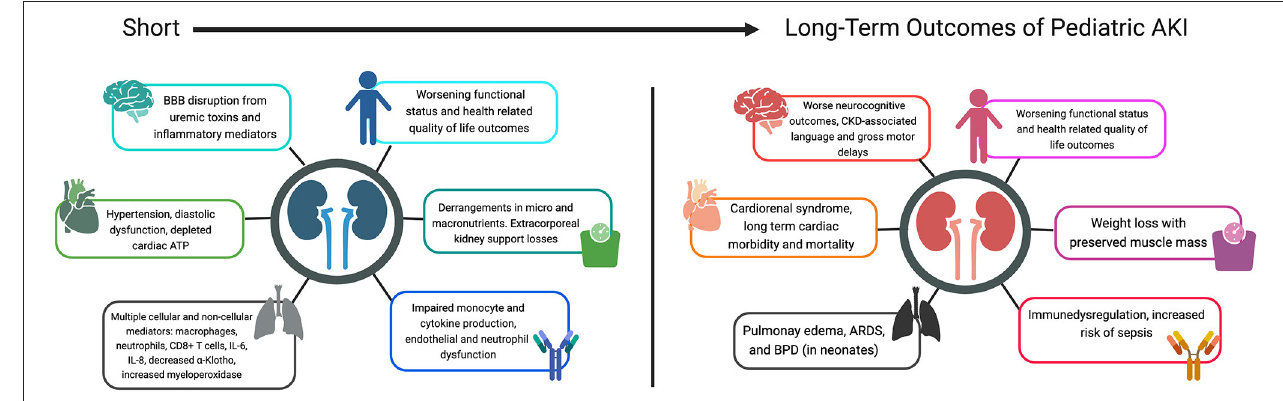
FIGURE 1 | Short and long term outcomes of pediatric AKI. BBB, blood-brain-barrier; ATP, adenosine triphosphate; CD8 + , cluster of differentiation 8; IL-, interleukin; CKD, chronic kidney disease; ARDS, acute respiratory distress syndrome; BPD, bronchopulmonary